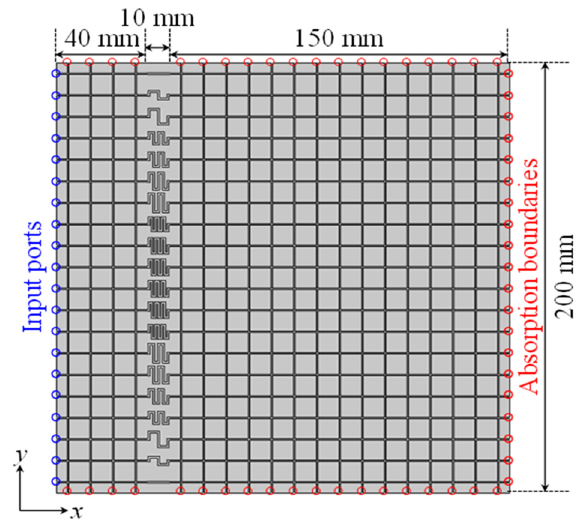
Figure 10. Configuration for full-wave simulations of the designed acoustic flat lens. The acoustic metasurface of 200 × 10 mm 2 in Figure 7 is sandwiched between two background media whose sizes are 200 × 40 and 200 × 150 mm 2 . The background media are composed of the structure of #5 in Figure 2. As is the case with Figure 8, twenty input ports are set to the left-hand side boundaries of acoustic waveguides and other boundaries are chosen as absorption boundaries.